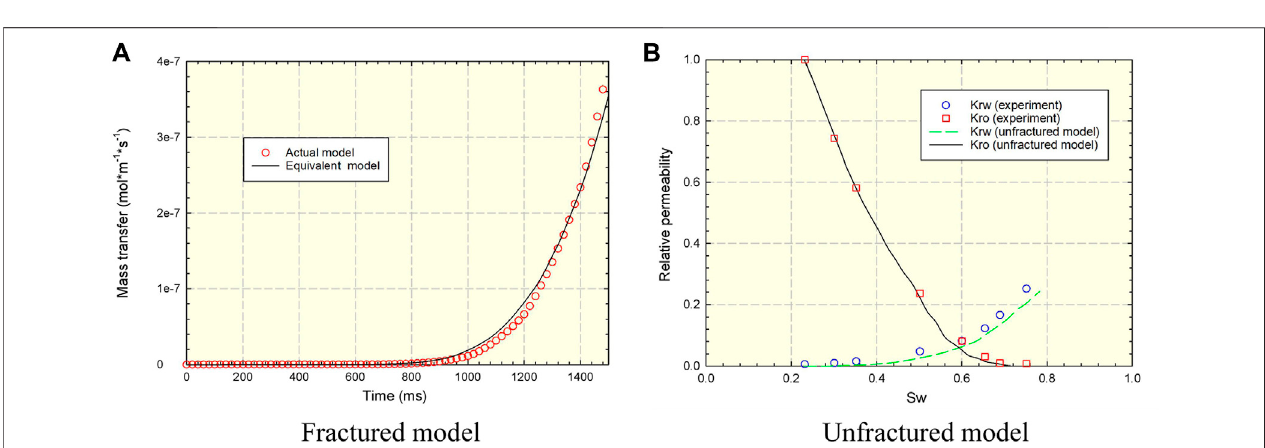
FIGURE 11 | Veri fi cation of the mass transfer model in porous media. (A) Fractured model and (B) unfractured model.